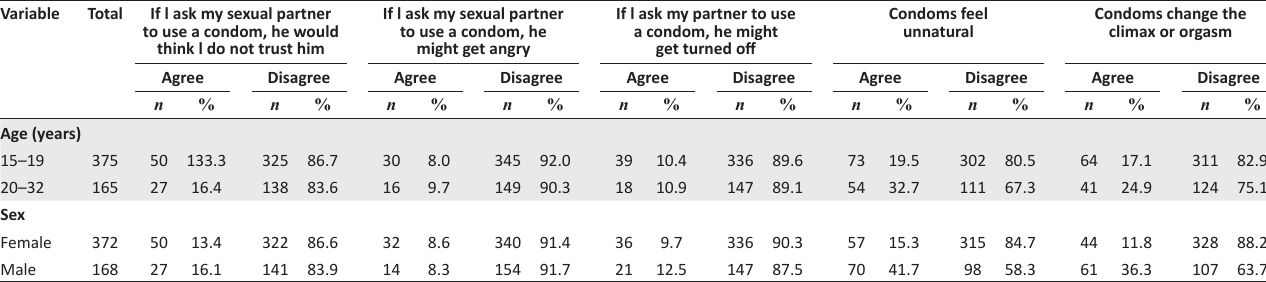
TABLE 4a: Student’s attitudes related to condom use.